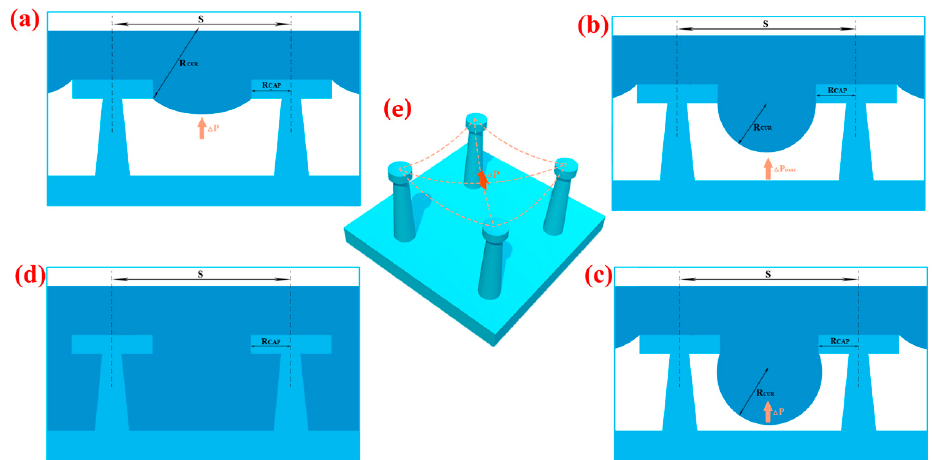
Figure 2. ( a – d ) the different states of mushroom-like pillars support the liquid. ( e ) Schematic of as-prepared mushroom-like pillars. (S is center-to-center spacing between two pillars, R CUR is the radius of the curvature of the lower concave surface, R CAP is the radius of the mushroom-like pillar caps, Δ P is additional pressure, and Δ P max is the additional maximum pressure)